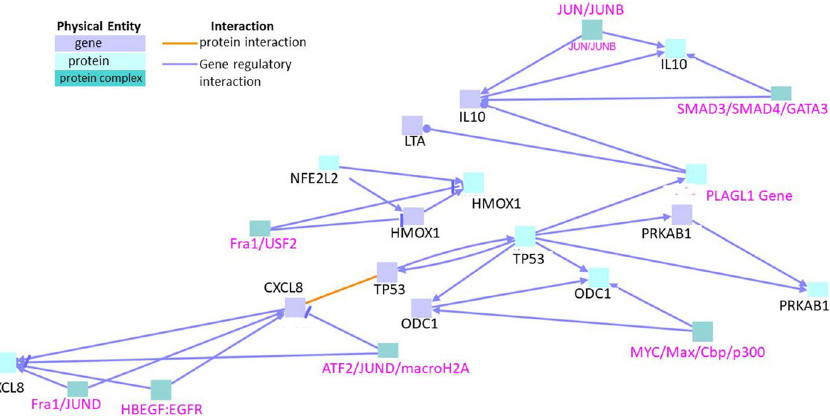
Figure 1. Interactions between genes that are exclusively upregulated in neurotoxicity. Black labels denote seed nodes and pink labels denote intermediate nodes. Each line represents an interaction. Line ending with an arrow represents stimulation whereas line ending with a small blunt line represents